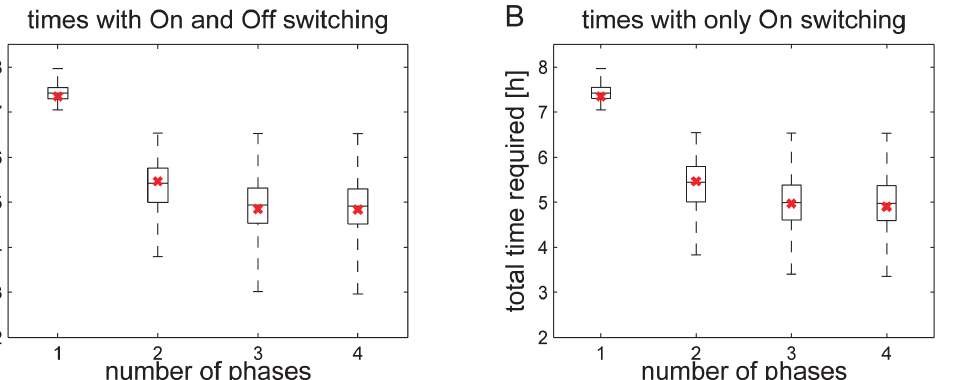
Fig 8. Robustness of optimal solutions. Possible variation ranges of the gain obtained with different numbers of metabolic phases and glucose and lactate as allowed substrates. (A) Genes can be switched on and off, (B) Genes can only be switched on. The red mark represents the base condition ( η j = 1 for j = 1, ... , n